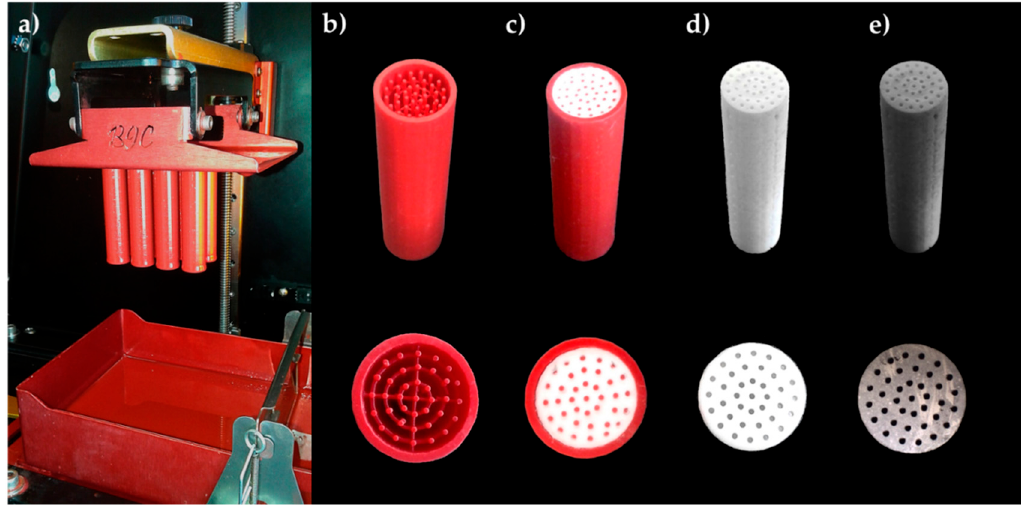
Figure 7. Application of 3D printing in indirect production of monolithic catalysts: ( a , b ) 3D-printed polymer matrices; ( c ) a matrix filled with ceramic material; ( d ) a catalytic support after removing the matrix; ( e ) a catalyst with the deposited active phase.